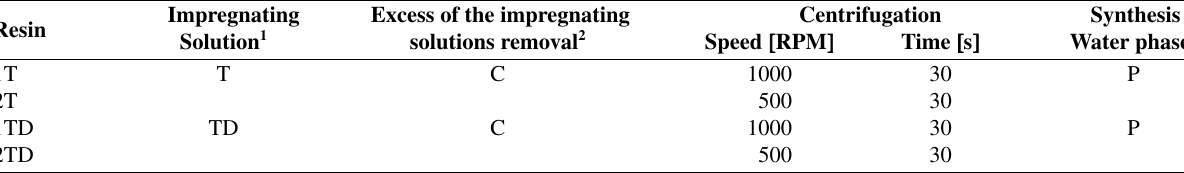
Table 1. Conditions of the core-shell IPNs’synthesis Impregnating Excess of the impregnating Centrifugation Resin Solution